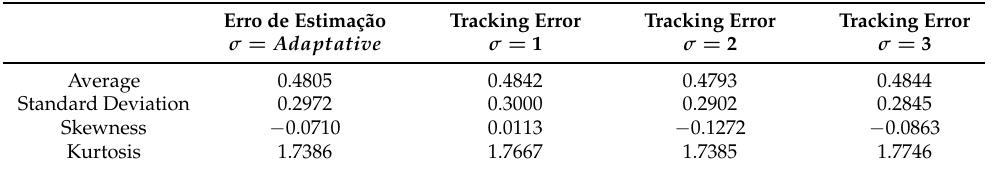
Figure 10. Histogram of the system estimation error. State of Charge—training result with the pres- ence of noise and outliers. Table 4. Statistical measures of the estimation error when the system is subjected to the presence of noise and